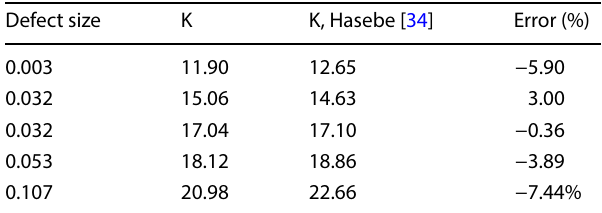
Table 3 7× LR stress intensity factors and errors 120-degree v-notch